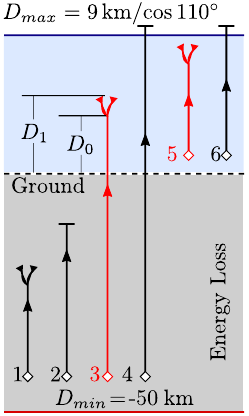
Figure 6. Possible outcomes of the τ simulations in NuTauSim. The height H fi in Fig. 4 corresponds to the distance D 1 , where the decay products of the τ